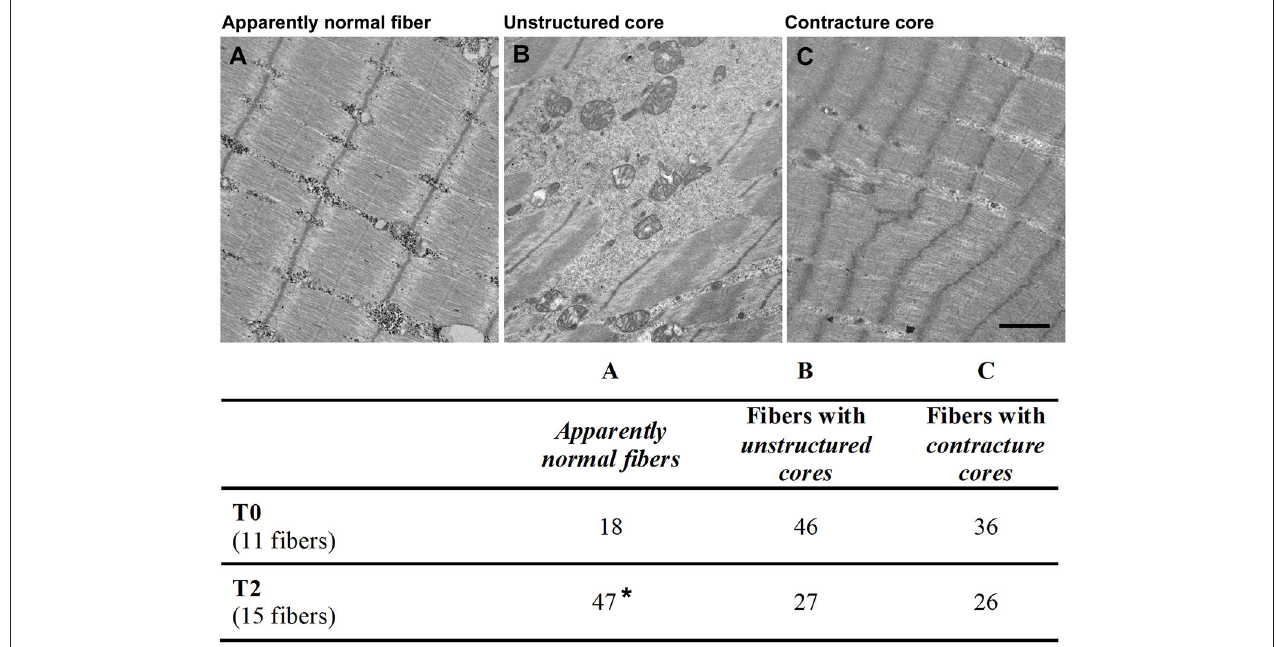
FIGURE 6 | Appearance of skeletal fibers in electron microscopy (EM). Fibers were classified by EM for the quantitative analysis in different categories: (A) apparently normal fibers (A) with a typical pale-dark striation; (B) fibers with unstructured cores , presenting extended areas in which myofibrils were disrupted and replaced by amorphous cytoplasmic material; (C) fibers with contracture cores , with extended regions with laterally-packed and over-contracted myofibrils. Scale bar: 1 µ m. Percentage, before (T0) and after 14 months (T2) were respectively reported in column A, B, and C. Data are expressed as % of total fibers analyzed; * p < 0.05 vs. T0.